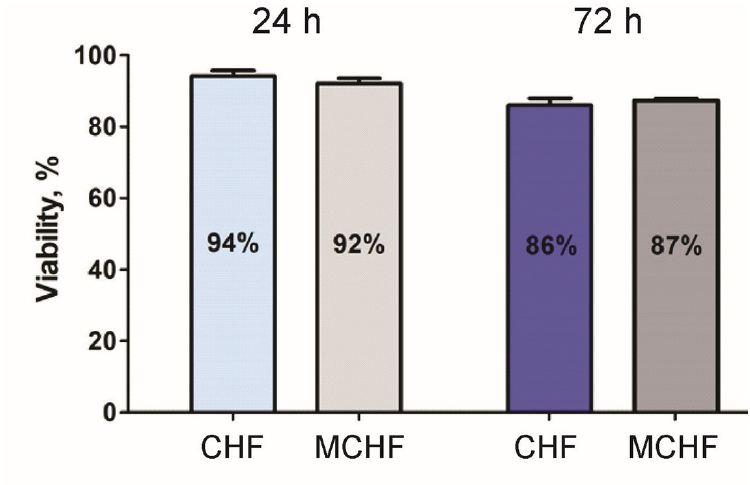
Figure 6. Cell viability assay of PVA-PEG-SiO 2 @PVA-GO core–shell fibers (CHF) and methanol- crosslinked core–shell fiber mats